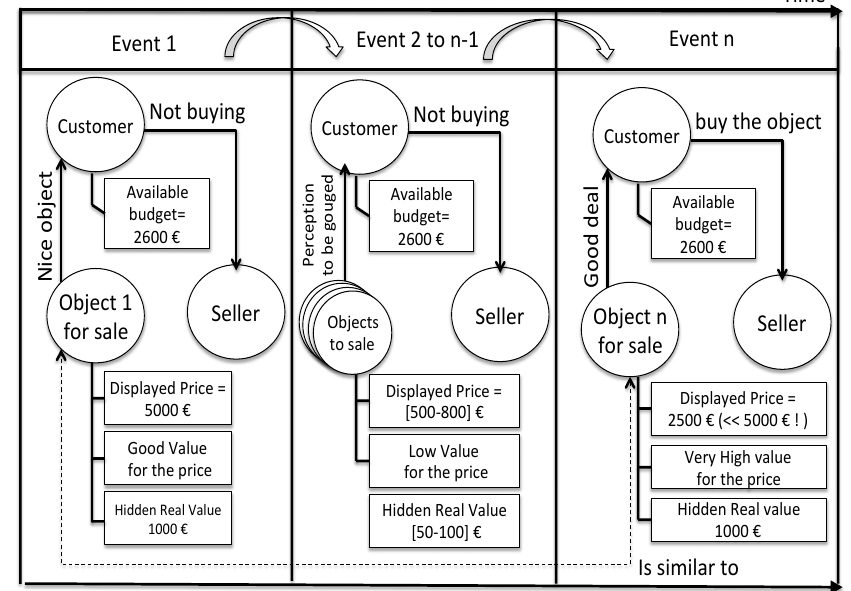
Figure 23. A graph of the emotion relation according to the OCC